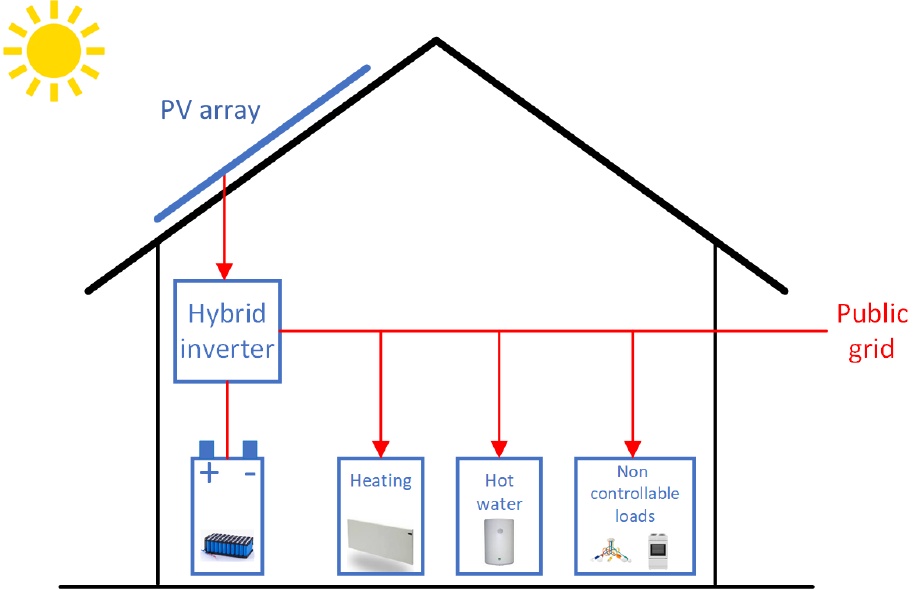
Figure 1. High-level model of the system. Line segments without arrow heads represent bidirectional power